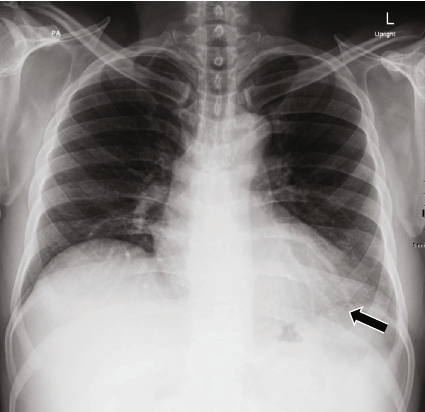
Figure 1: Upright PA chest X-ray showing faint opacity in the lower zone of the left